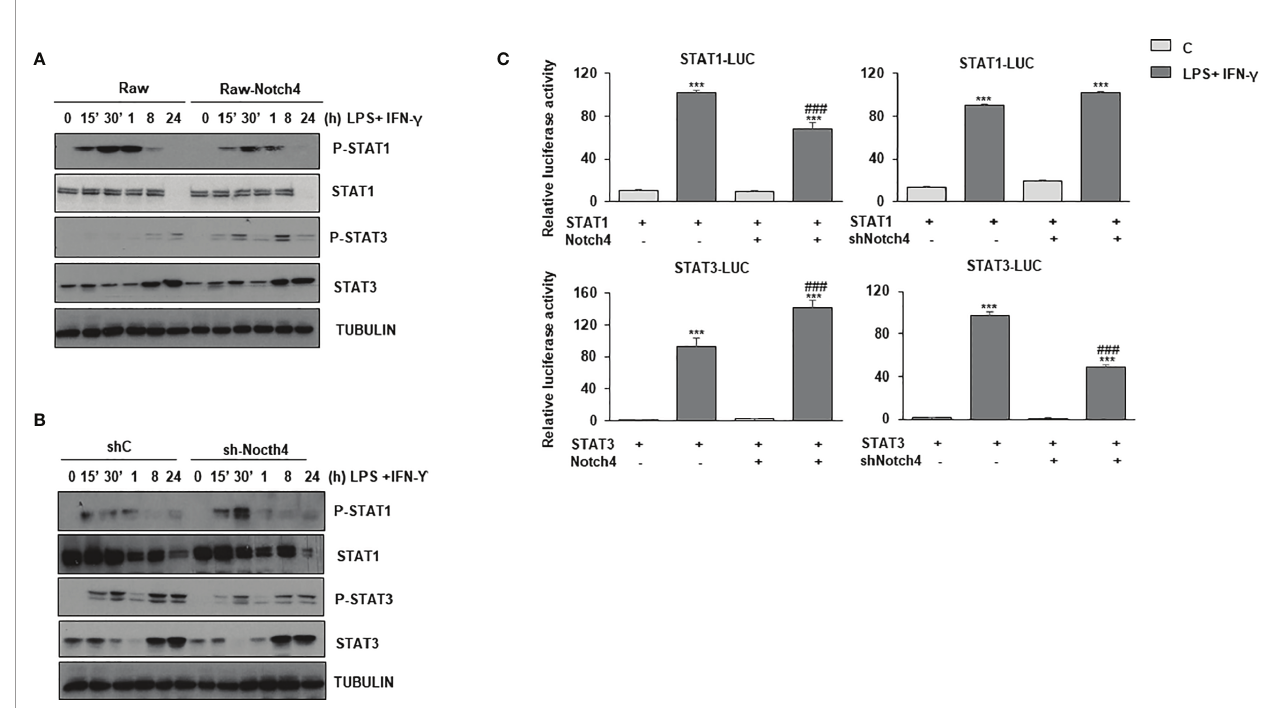
FIGURE 4 | Effect of NOTCH4 expression on the phosphorylation and activation of STAT1 and STAT3 in macrophages activated with IFN- g and LPS. Analysis by Western blot of STAT1 and STAT3 tyrosine phosphorylation in Raw 264.7 cells transiently transfected with a Notch4 expression vector or the corresponding empty vector (A) , or with speci fi c shRNA for Notch4 gene or control shRNA (B) . One day after transfection, cells were stimulated with LPS (100 ng/ml) and IFN- g (10 U/ml) for different times before analysis. A representative experiment out of three is shown. (C) Analysis of luciferase activity in Raw 264.7 cells transiently transfected with a STAT-luciferase reporter in the presence of STAT1 (STAT1-LUC) (upper panels) or STAT3 (STAT3-LUC) (Lower panel) and a Notch4 expression vector or the corresponding empty vector (right panels) or with speci fi c shRNA for Notch4 or control shRNA (lefth panels). One day after transfection, cells were stimulated with LPS (100 ng/ml) and IFN- g (10 U/ml) for 24 h before analysis. The means ± SD of three independent experiments are shown. One-way ANOVA/Bonferroni ’ s post- tests were performed. ***p<0.001 compared to the control transfected cells. ### p<0.001 compared to LPS and IFN- g treated control transfected